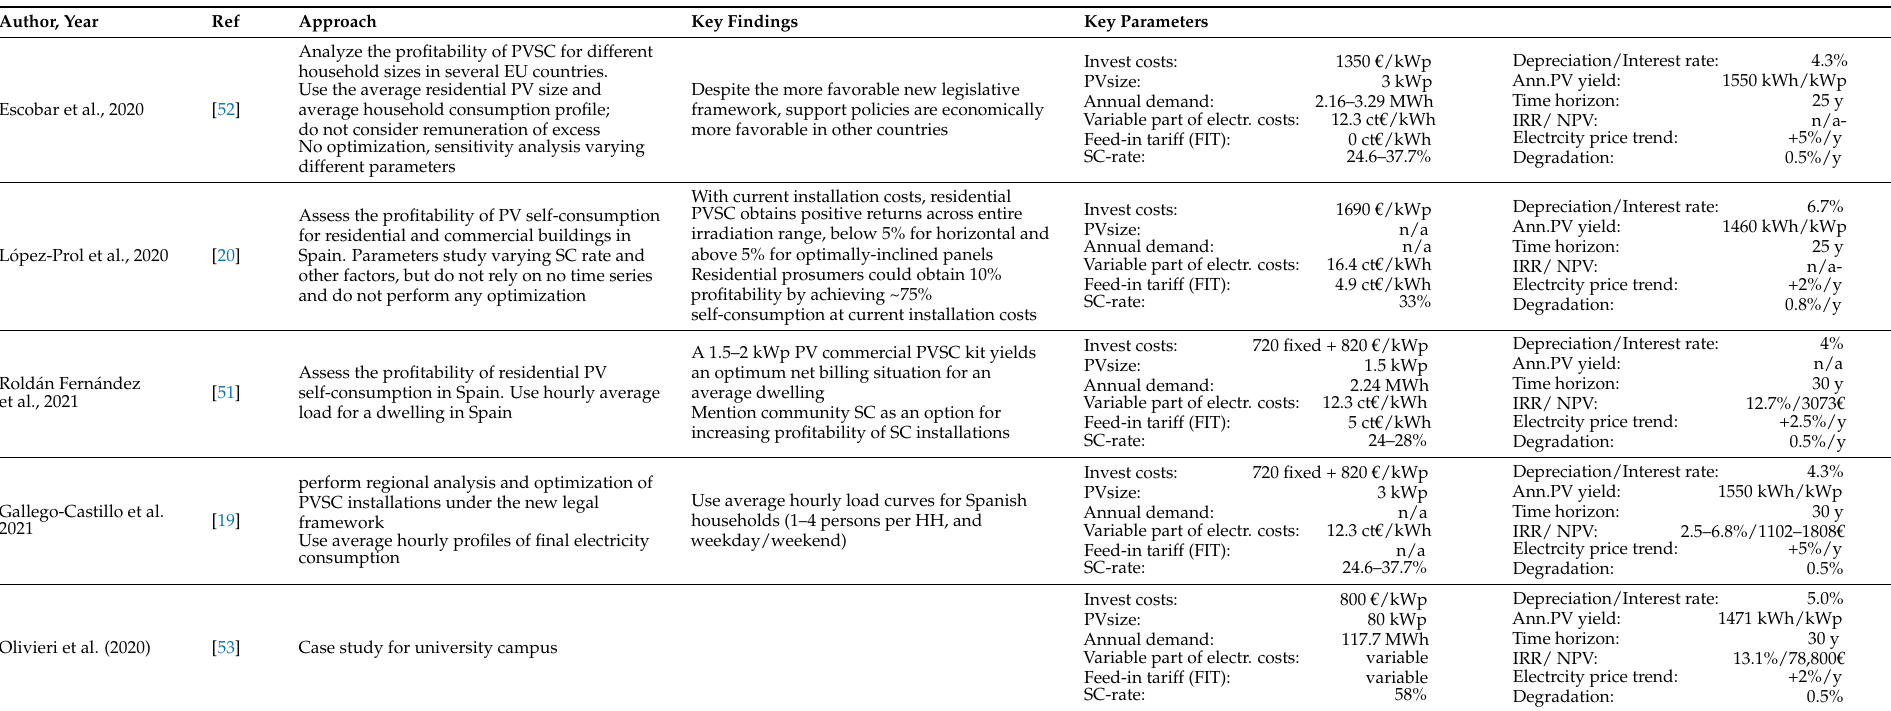
Table 1. Literature review results: summary of the key findings and modeling parameters of the relevant case studies on the profitability of PVSC in the Spanish context published after RD-L 15/2018 and RD 244/2019. All prices in the table refer to the year of the corresponding study i.e., 2020/2021 according to the year of